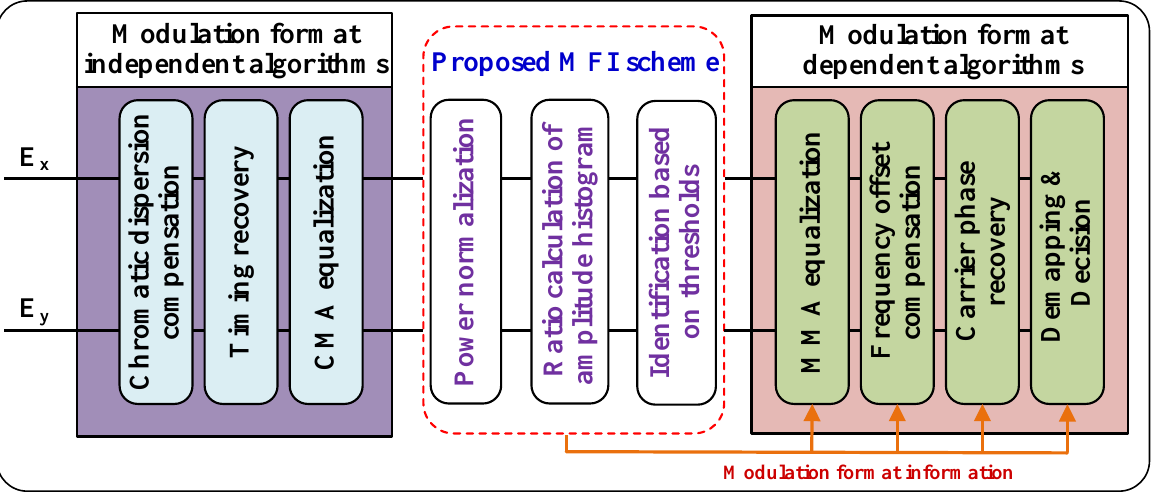
Figure 1. The DSP architecture with the proposed MFI scheme for autonomous digital coherent re- ceivers.